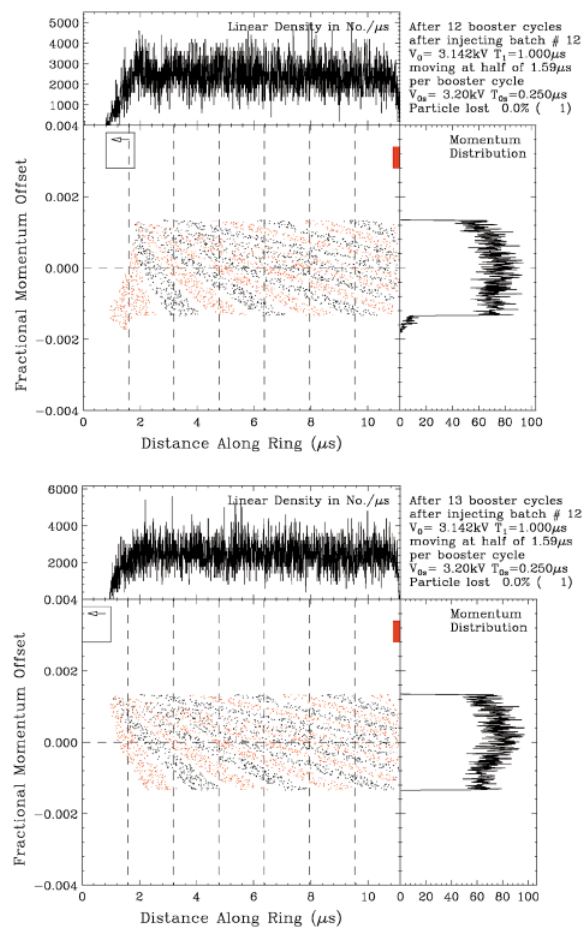
FIG. 7. (Color) Continuing the injection from Fig. 6. Top: One booster cycle after the injection of the 12th batch between 0.0 T b and 1.0 T b , or 12 booster cycles after the injection of the first batch. Bottom: Another booster cycle later or 13 booster cycles after the injection of the first batch. All particles are within the designated final momentum spread and adiabatic capture can